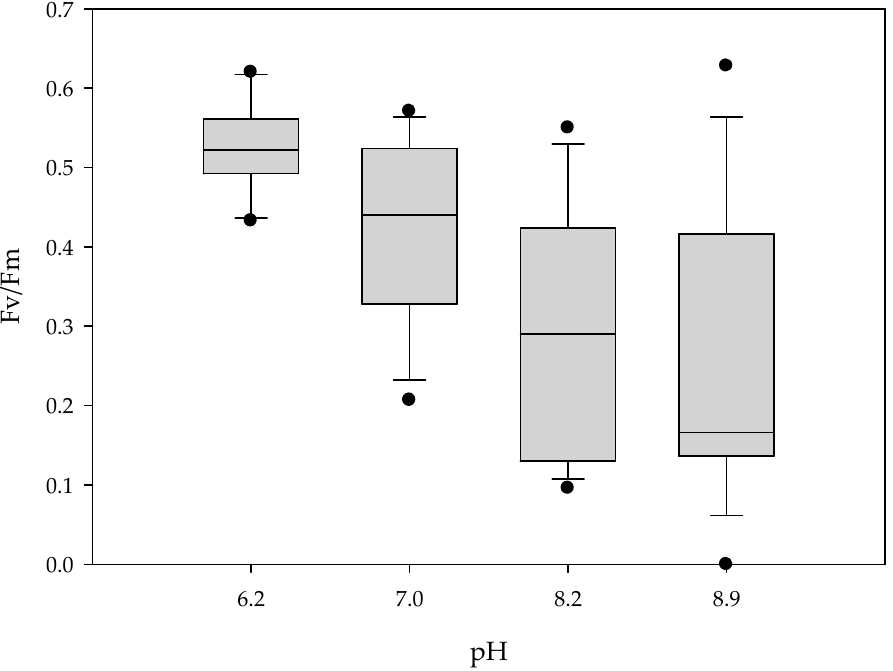
Figure 3. Box plot showing F v /F m in response to different pH levels 21 days after the start of the treatment of R. fortunei seedlings ( n = 16) (Exp 2). The Φ PSII of the seedlings decreased from 0.393 ± 0.012 to 0.339 ± 0.013 in the control and from 0.384 ± 0.008 to 0.306 ± 0.012 at pH 7.0 on day 1 and day 21, respectively. How- ever, during this period the Φ PSII decreased rapidly from 0.390 ± 0.013 to 0.230 ± 0.023